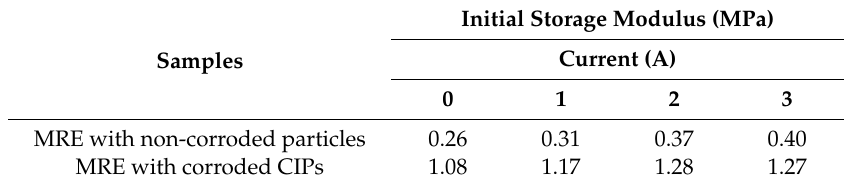
Table 4. Initial storage modulus for MRE with non-corroded and corroded CIPs at different current.